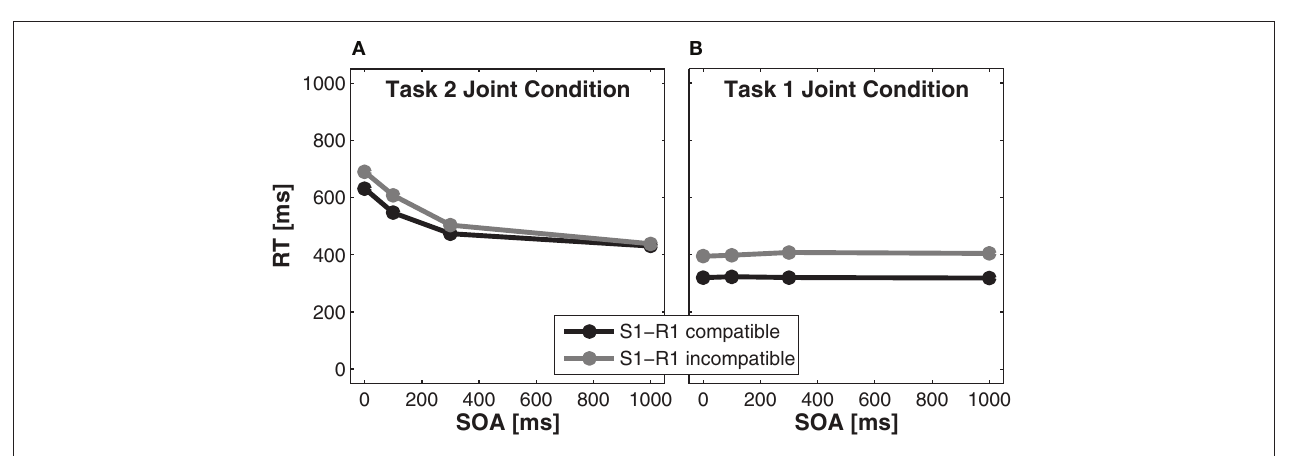
FIGURE 4 | Effects of stimulus onset asynchrony (SOA) on reaction times of Task 2 (A) and Task 1 (B) of the joint condition for S(timulus)1-R(esponse)1 compatible trials (black solid lines) and S1-R1 incompatible trials (gray solid lines).